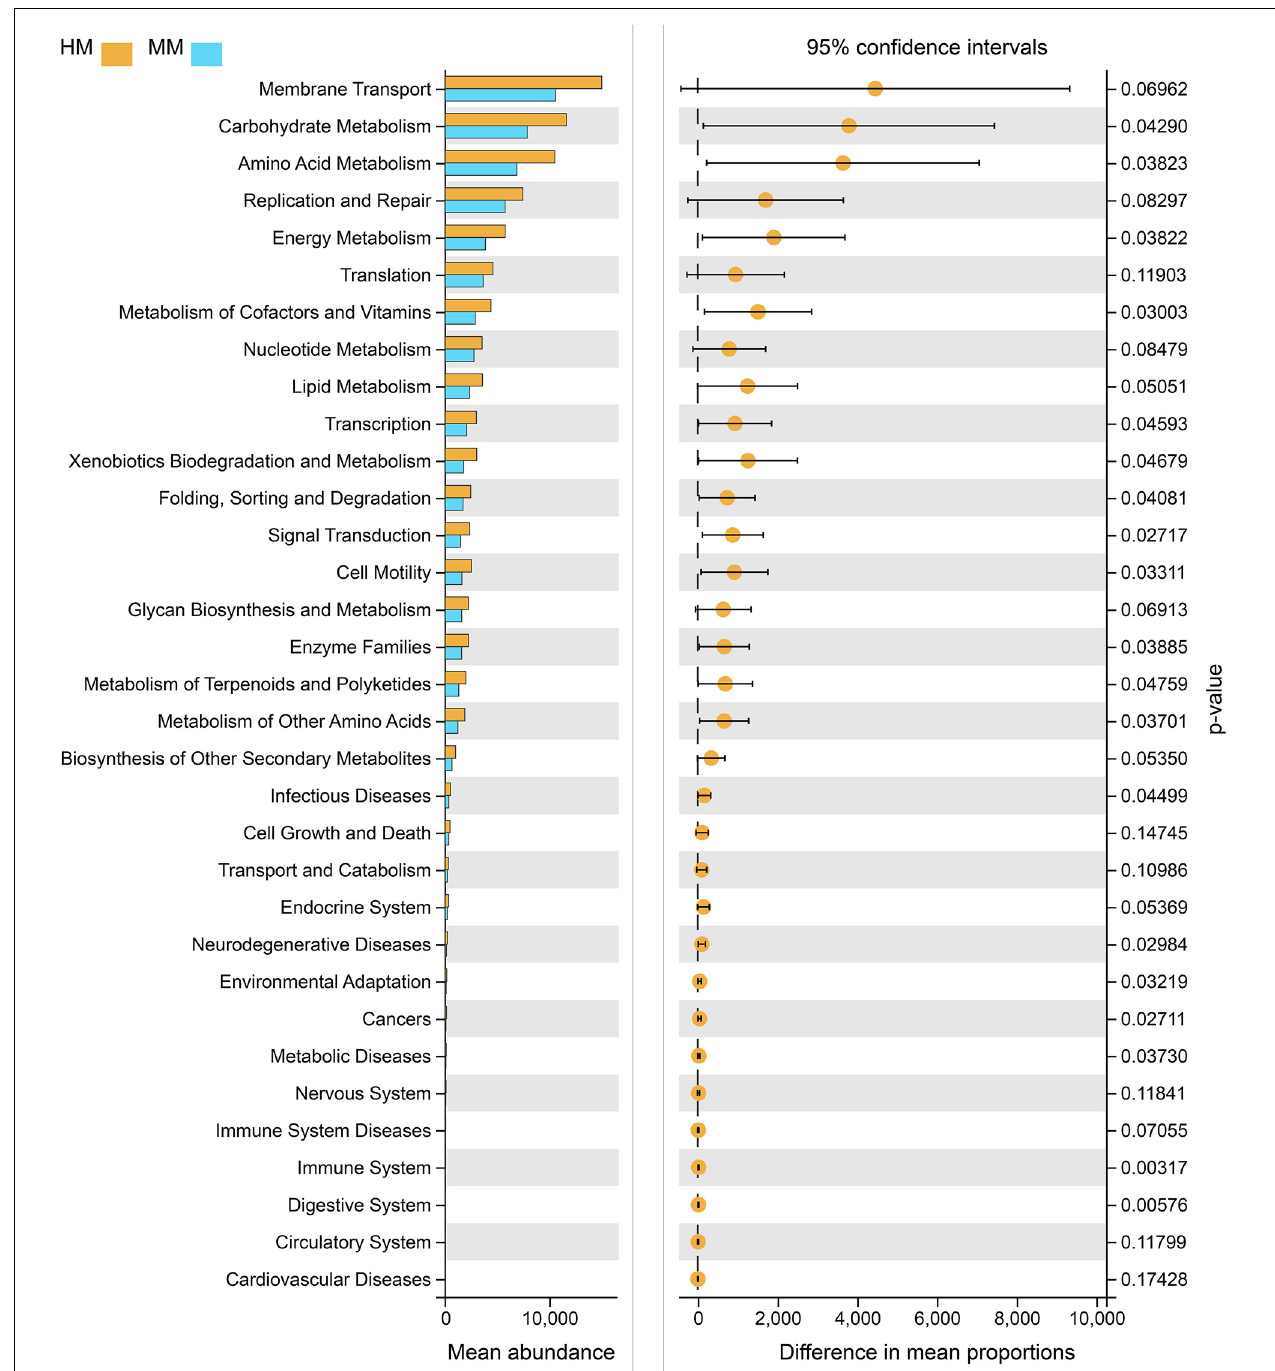
FIGURE 8 | PICRUSt analyses using Welch’s t -test between human milk and mare milk. 95% confidence intervals, p <